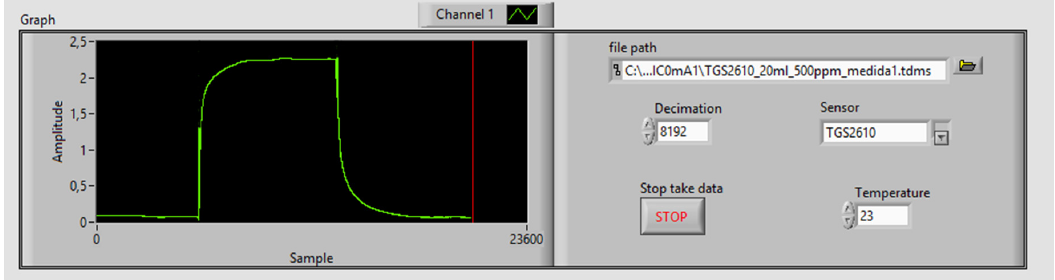
Figure 9. Graphical user interface of the LabVIEW program used to store measures.